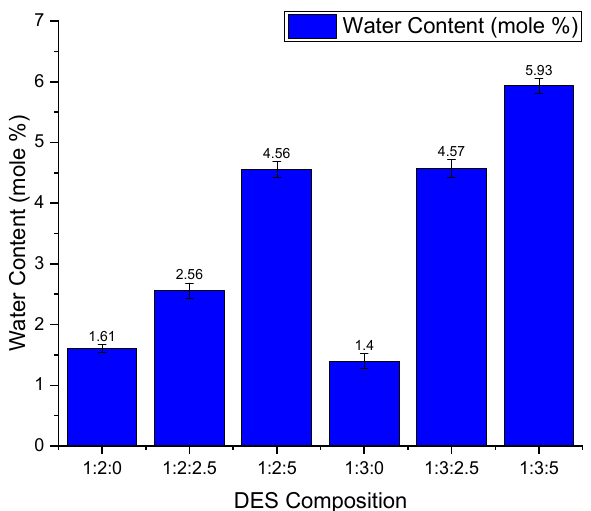
Figure 7. Water content (mole %) in different ChCl:LvAc DES compositions.